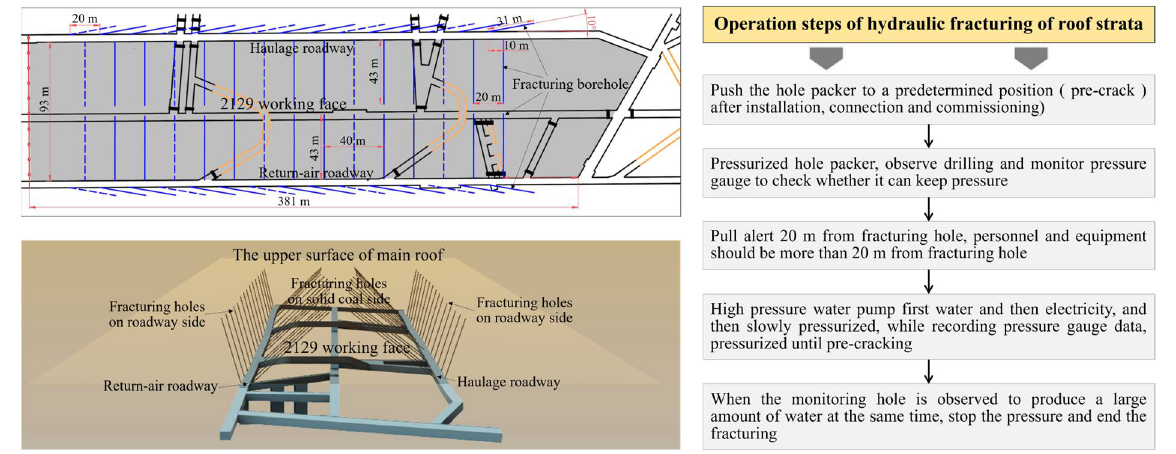
Figure 7. Hydraulic fracturing technology for roof-cutting.